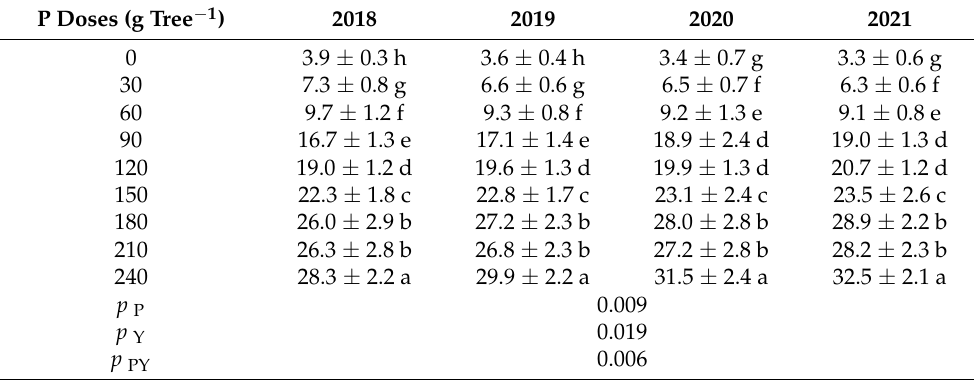
Table 2. The effect of P doses on the degree of P saturation (% DPS) during 2018–2021. Means ( ± SE, n = 4) denoted by different letters indicate significant difference according to Duncan’s test at p < 0.05. p is p value of the ANOVA test. P = phosphorus doses, Y = year, and PY = interaction of P and Y. P Doses (g Tree − 1